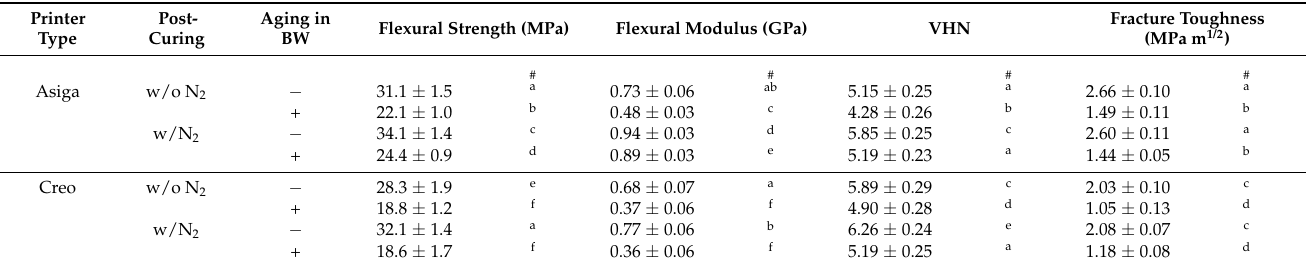
Table 2. Mean values and standard deviations of flexural strength, flexural modulus, VHN, and fracture toughness, and results of 1-way ANOVA statistical